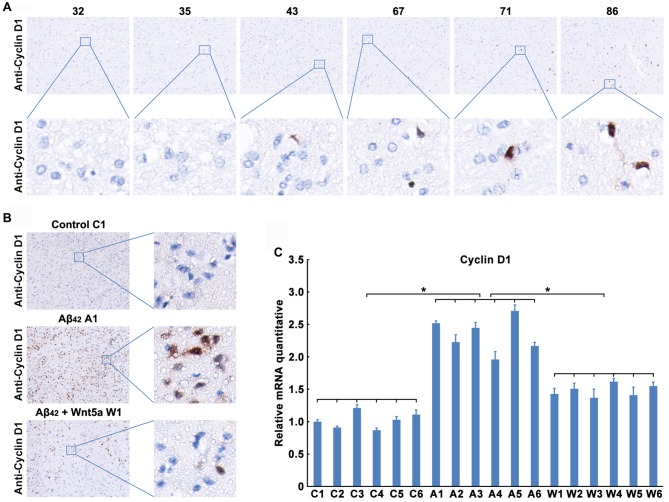
Wnt5a inhibits the expression of Cyclin D1 in vivo. (A) Cyclin D1 immunoreactivity was primarily detected in the adjacent normal brain tissues of malignant glioma from 32, 35, 43, 67, 71 and 86 years old patients (magnification of upper panel: ×40; magnification of lower panel: ×400). (B,C) A solution of Aβ42 (3 nmol/10 μl) or Aβ42 (3 nmol/10 μl) combined with recombinant Wnt5a protein (6 nmol/10 μl) was injected into the lateral ventricles of mice. Seven days after treatment, Cyclin D1 immunoreactivity was primarily detected in mouse brain tissues (B, control C1: control group mouse 1; Aβ42 A1: Aβ42 treated group mouse 1; Aβ42 + Wnt5a W1: Aβ42 and Wnt5a treated group mouse 1; magnification of left panel: ×40; magnification of right panel: ×400), total RNA was extracted and analyzed by Q-PCR (C, C1–C6: control group mouse 1–6; A1–A6: Aβ42 treated group mouse 1–6; W1–W6: Aβ42 and Wnt5a treated group mouse 1–6). All data in this figure represent the means ± SEM of three independent experiments. *P < 0.05.